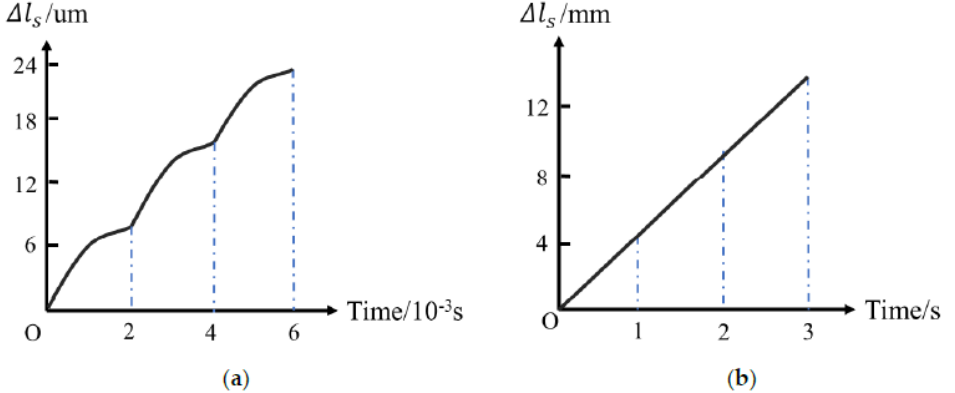
Figure 9. The relationship curve between the linear displacement of the shaft and time. ( a ) Within three periods; ( b ) within 3 s.